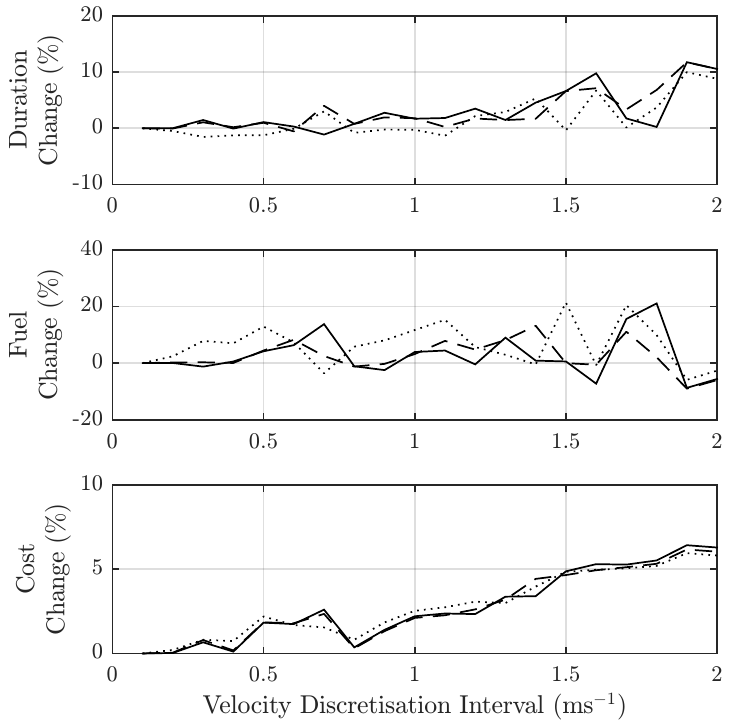
Figure 13. Optimization results as a function of the velocity discretisation interval, with journey time change (top), fuel consumption change (middle) and total cost change (bottom), using λ = 0.5 and three separate road